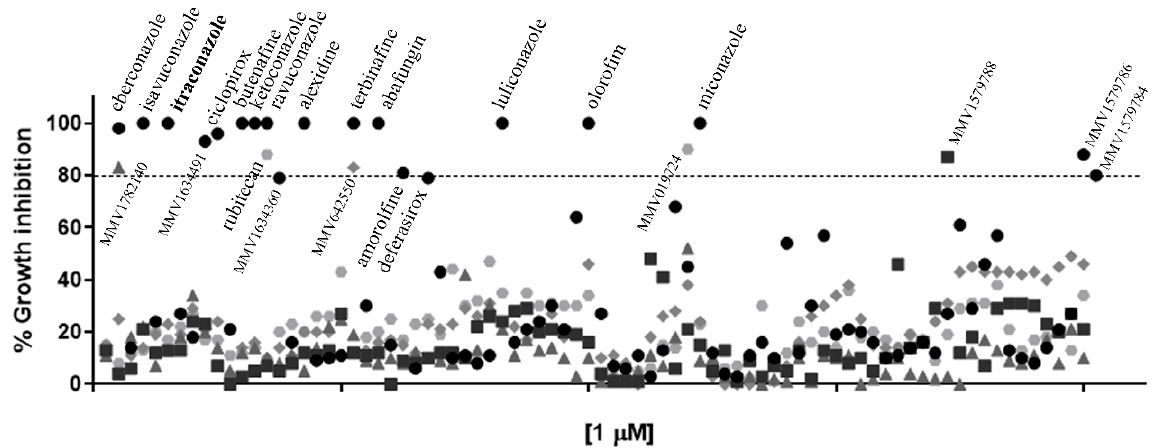
Figure 1. Growth inhibition of Sporothrix brasiliensis yeasts after exposure to the 400 compounds of the Pandemic Response Box library for 48h. Itraconazole (in bold) is the antifungal recommended for sporotrichosis treatment. Results are shown as the mean of percent growth relative to the untreated control. Table 1. Inhibitory effects of twenty-four compounds on the pathogenic Sporothrix species.